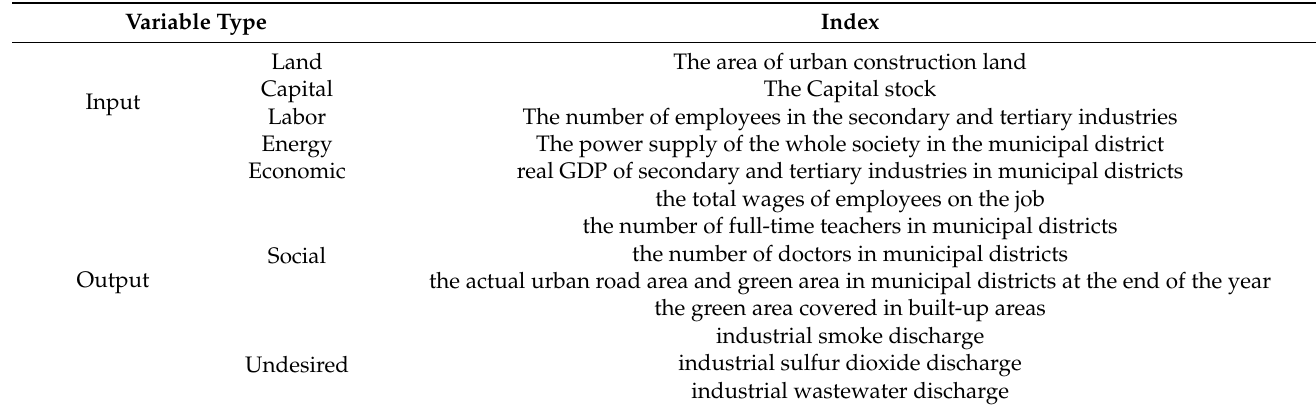
Table 2. Input-output index